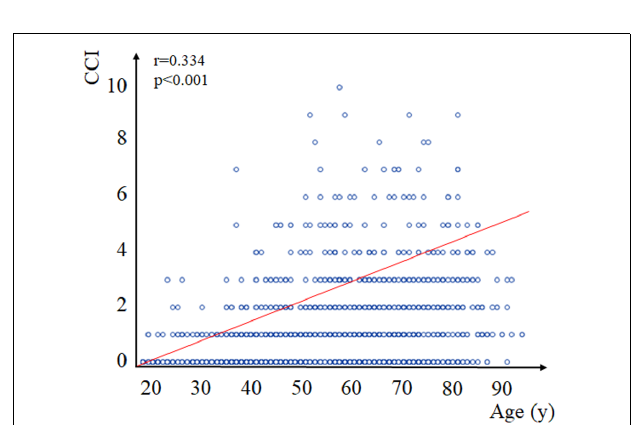
FIGURE 3 | Correlation between age and Charlson Comorbidity Index (CCI). Spearman’s correlation established a significant positive correlation of moderate strength ( r = 0.334, p < 0.001) between age on admission and CCI. CCI, Charlson Comorbidity Index.